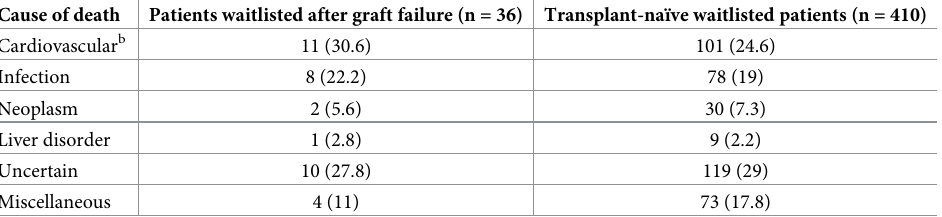
Table 3. Causes of death among patients who remained on the waiting list a (n = 1876 patients and 446 deaths) after allograft failure versus transplant-naïve waitlisted